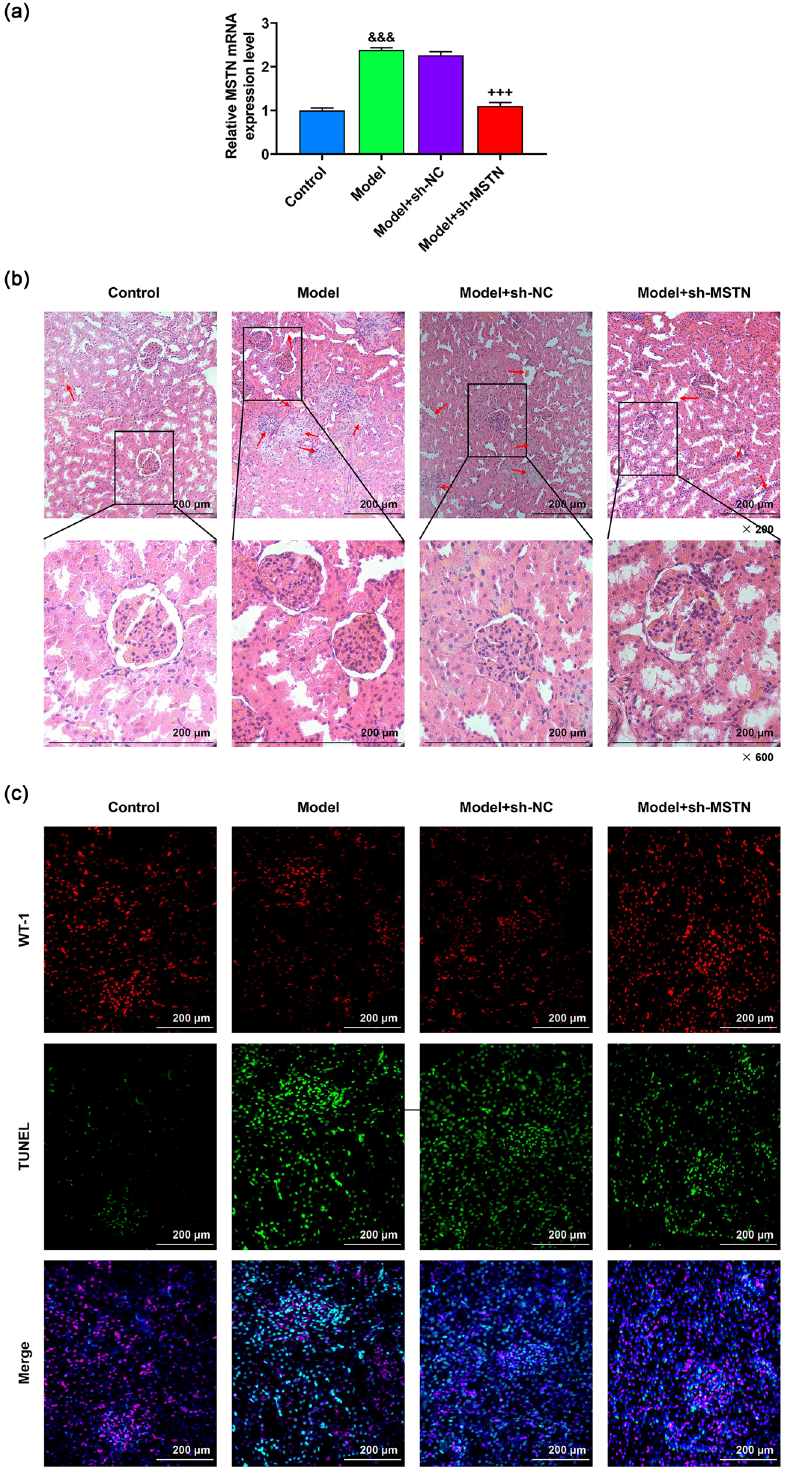
Figure 7: E ff ect ofsh - MSTN on the kidneyinjuryin MNmodel rats. MN model rats were inducedbyc - BSAand theninjectedwith 30pmol/g ofsh - MSTN or sh - NC. ( a ) Expression of MSTN in kidney tissues of rats in the control, model, model + sh - NC and model + sh - MSTN groups was detected by qRT - PCR, withGAPDHservingastheinternalreference. ( b ) H&Estainingwasadoptedtoevaluatetherenalpathologicalstatusofratsineachgroup ( magni fi cation × 200, × 600,scalebar = 200µm ) . ( c ) TUNELassaywasutilizedtodeterminetheapoptosisofratrenalcellsineachgroup ( magni fi cation × 200,scalebar = 200µm ) . All experiments were repeated three times to obtain average values. The data are expressed as the mean ± SD of three independent experiments; &&& p < 0.001 vs control; +++ p < 0.001 vs Model + sh - NC. Abbreviation: MN, membranous nephropathy; MSTN, myostatin; GAPDH, glyceraldehyde - 3 - phosphate dehydrogenase; H&E, hematoxylin and eosin; TUNEL, terminal deoxynucleotidyl transferase - mediated dUTP nick end labeling; sh - MSTN, short hairpin RNA targeting MSTN; sh - NC, shRNA negative